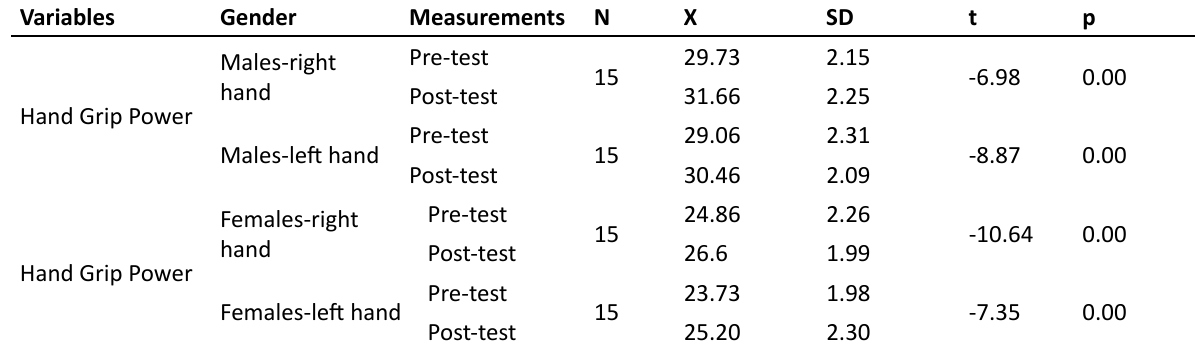
Table 3. The Hand Grip Power Pre-test and Post-test Results of Participant Females and Males Variables